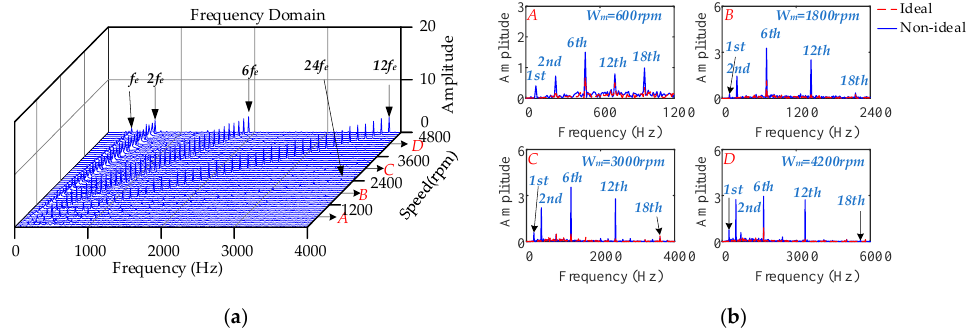
Figure 27. Frequency domain results of electromagnetic torque under different speeds: ( a ) waterfall diagram of electromagnetic torque; ( b ) comparison results of electromagnetic torque.